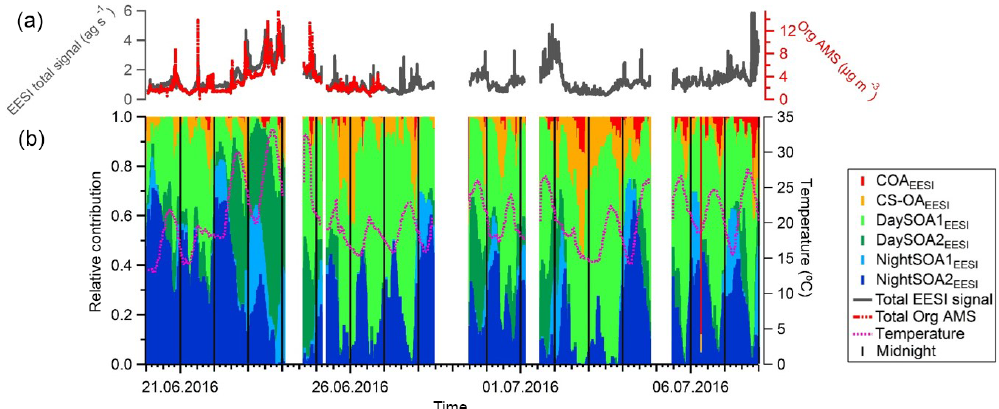
Figure 11. (a) Total signal from the EESI-TOF-MS (ags − 1 ) and total organic mass concentration measured with the AMS (µgm − 3 ). (b) Relative contributions of the EESI-TOF-MS factors to the total signal. Vertical black lines denote midnight.